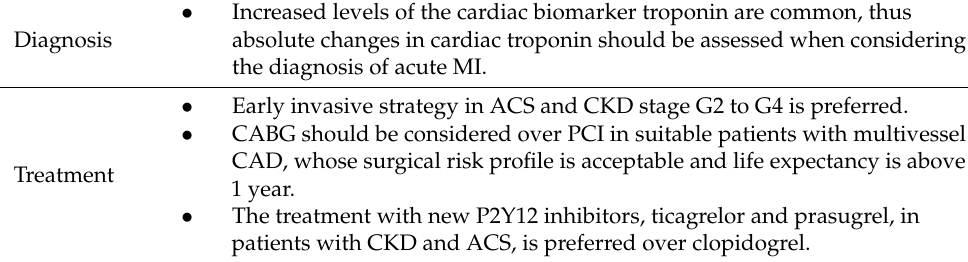
Table 3. Key messages in acute coronary syndrome and kidney